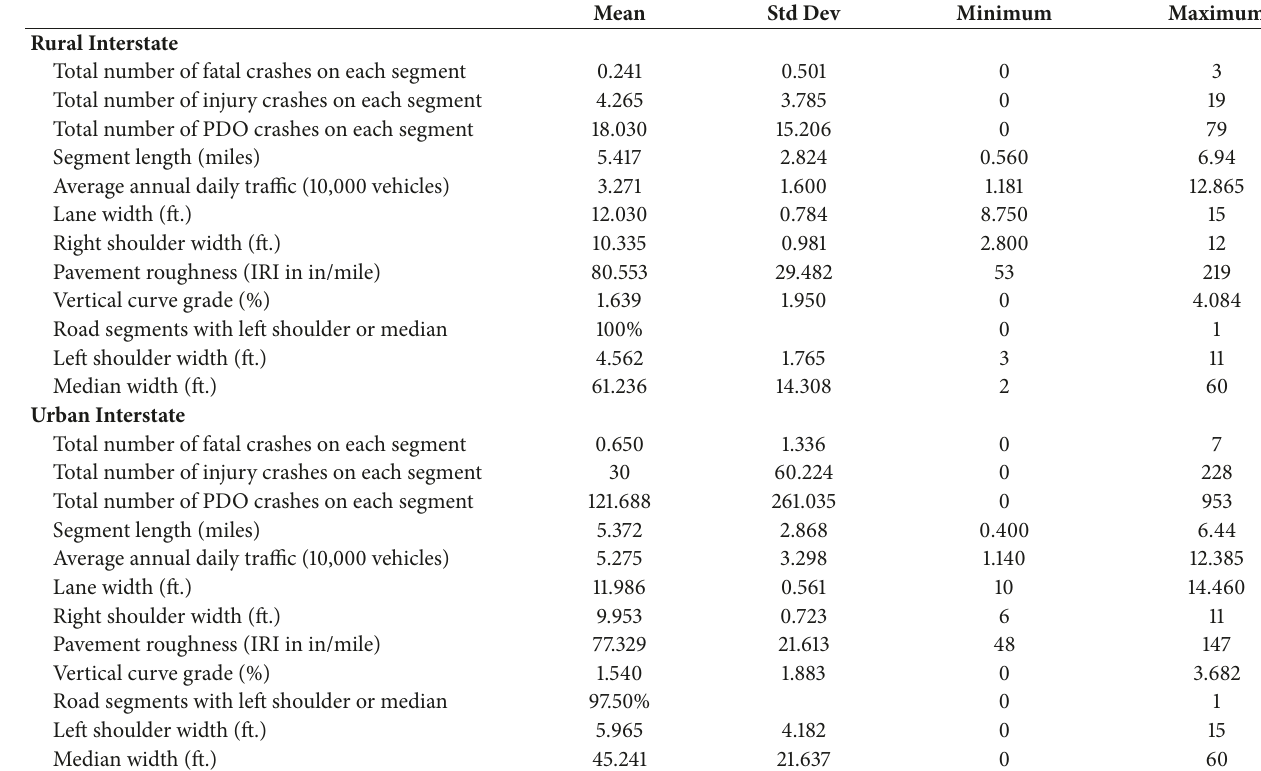
Table 1: Descriptive statistics of